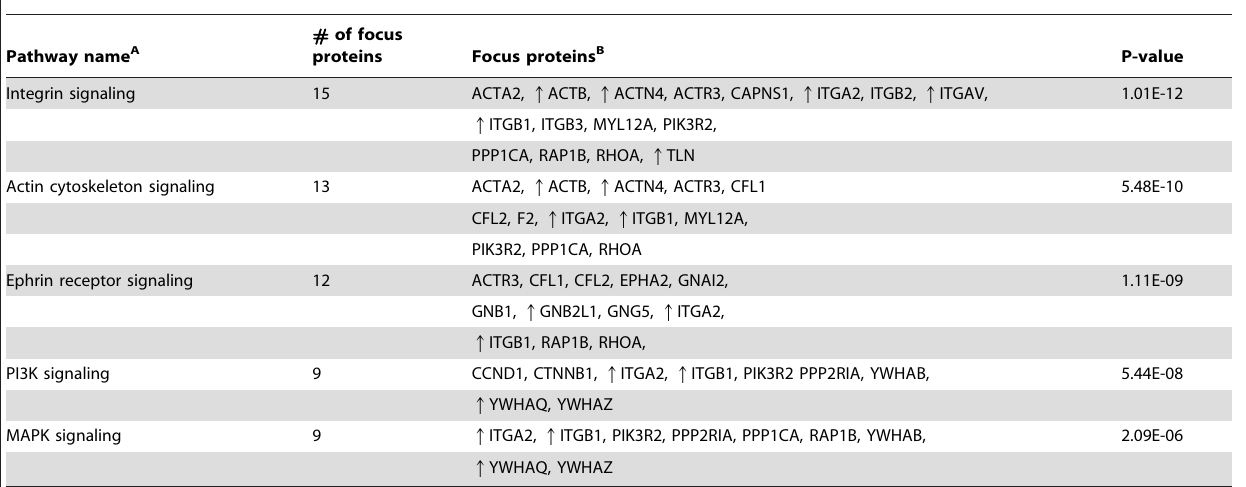
Table 3. Top five signaling pathways associated with cell to cell signaling network.